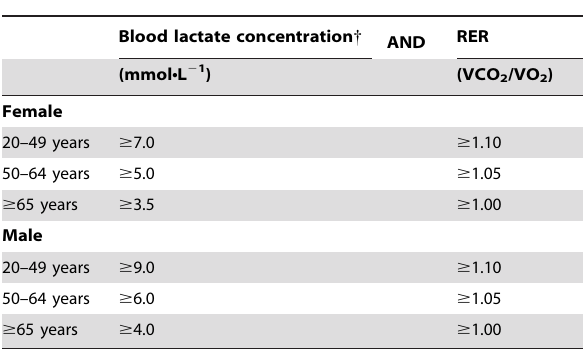
reach 85% of the HR predicted, and 79 subjects (10%) did not reach 95% of the HR predicted. End Criteria and Impact on Oxygen Uptake